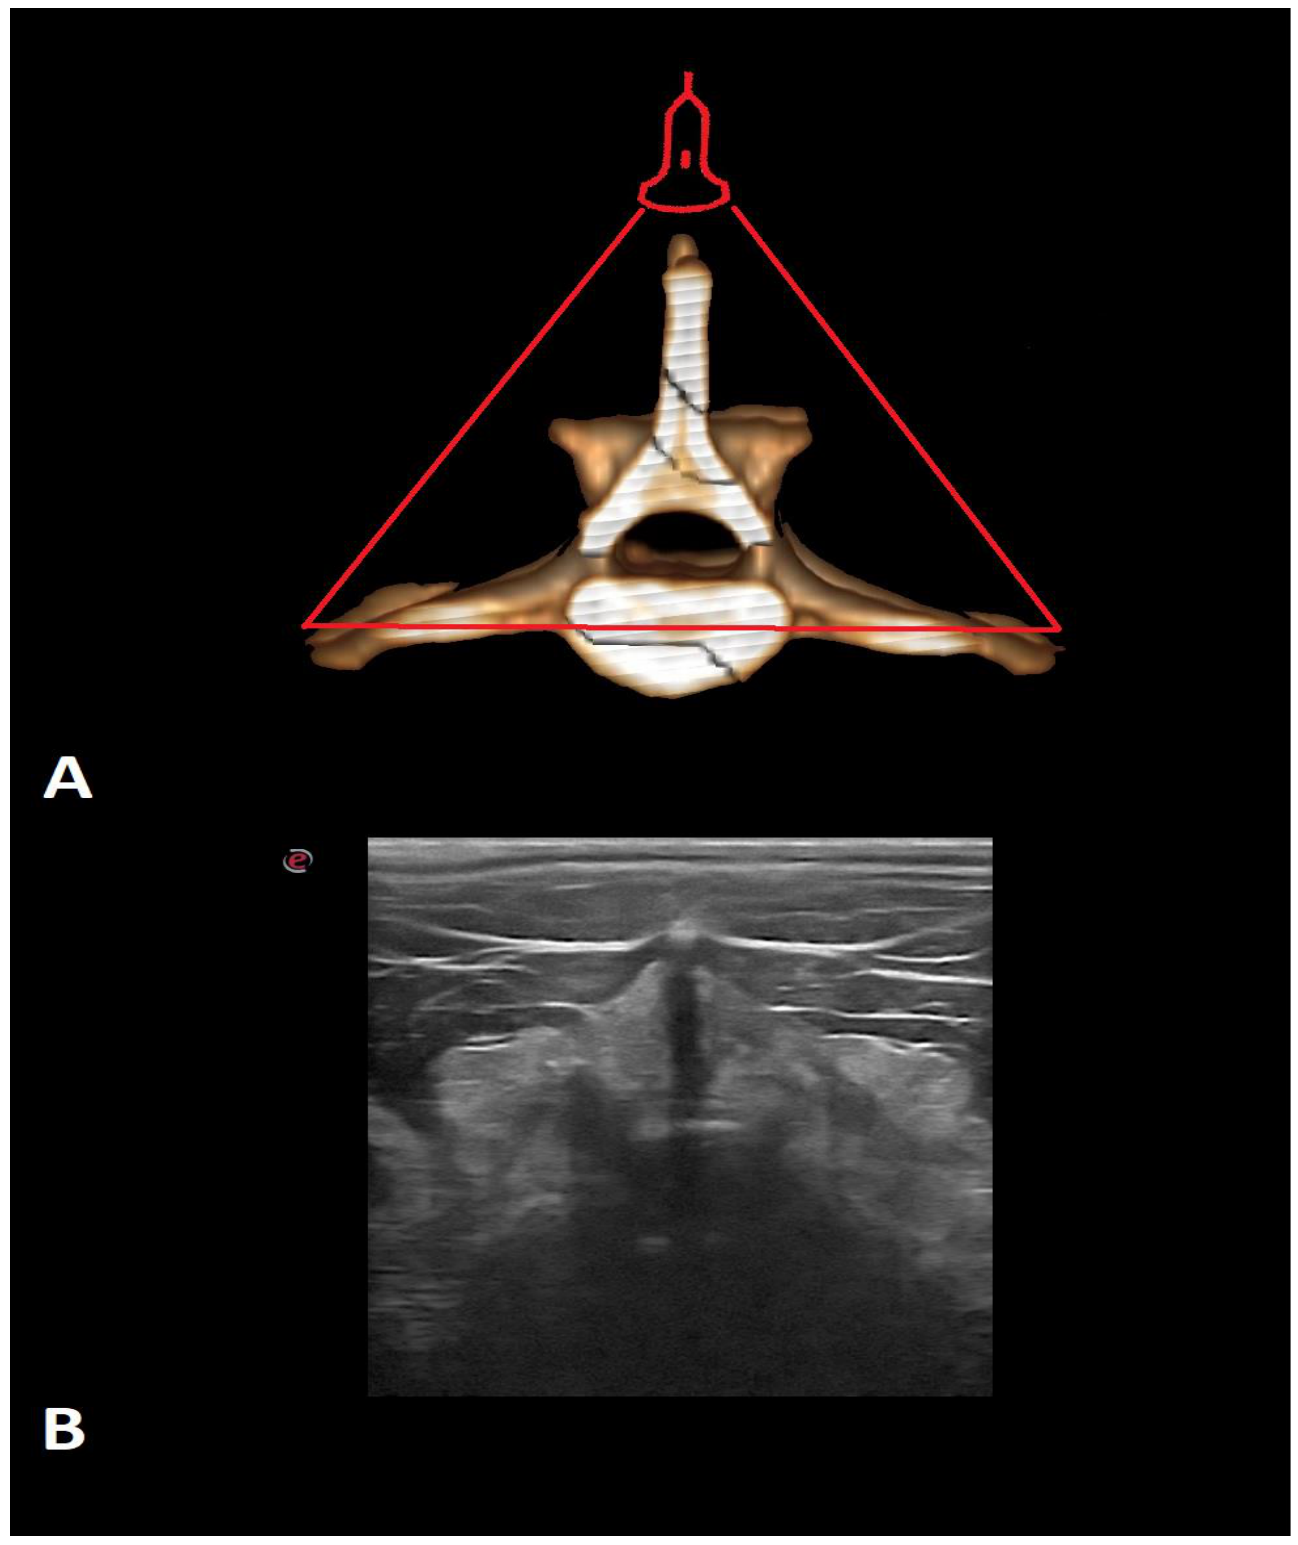
Figure 2. The 3D CT scan ( A ) and ultrasonographic image of the transverse midline plane ( B ) of the lumbar vertebra of the dog. The red triangle indicates the place on the spine where the probe was applied.